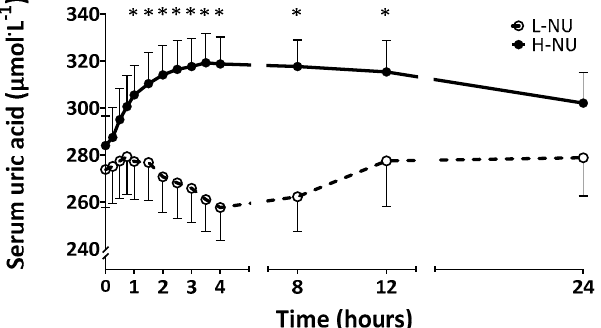
Figure 1. Temporal response of serum uric acid concentrations during a 24 h period following the consumption of a nucleotide-depleted (L-NU) or nucleotide-rich (H-NU) mycoprotein-based mixed meal in healthy young adults ( n = 10). Data were analysed using a two-way ANOVA and Bonferroni post-hoc tests. Values are means with SEM represented by vertical bars. Main effect of time ( P < 0.01), condition ( P > 0.05) and time x condition interaction ( P < 0.0001). * denotes significantly different from corresponding baseline value.